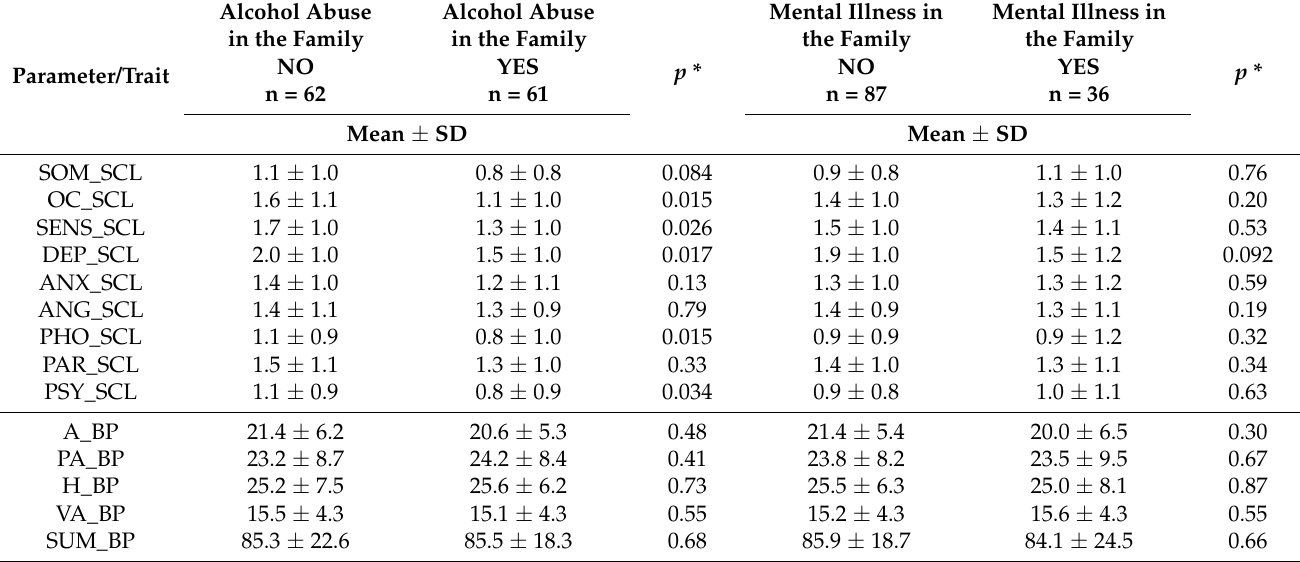
Table 3. Comparative analysis of selected psychological traits of adolescents, depending on alcohol abuse in the family and the occurrence of mental illness in family members. o